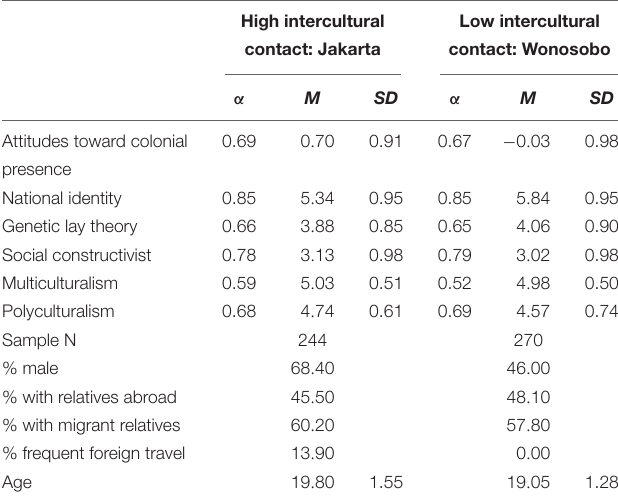
TABLE 4 | Descriptive statistics for two Indonesian